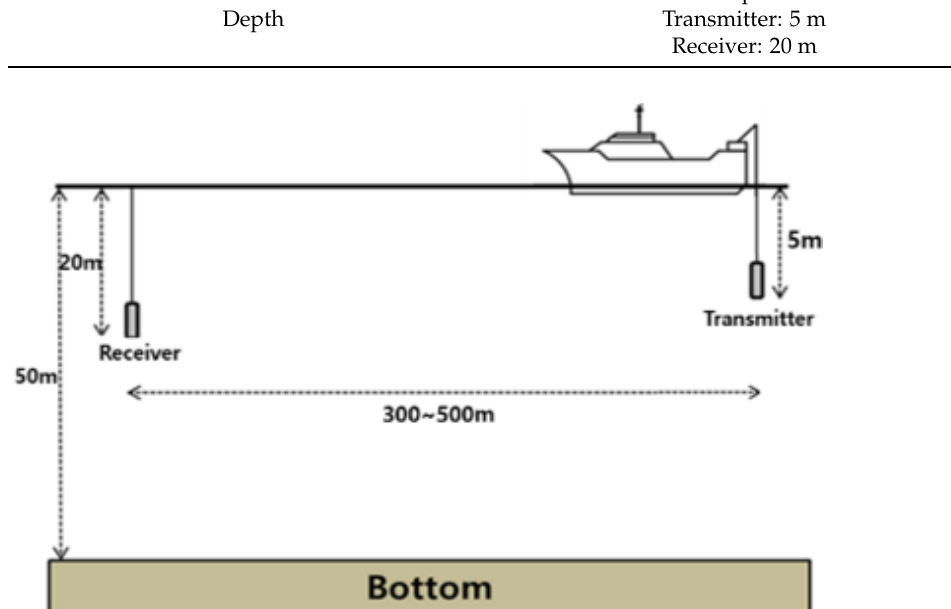
Figure 6. Deployment of the lake trial.